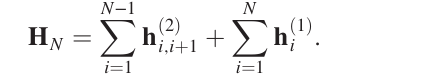
H ⊕ 0 þ 0 ⊕ H C þ dense Þ trivial